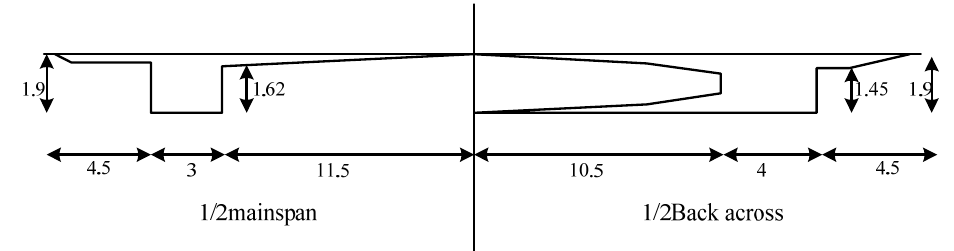
Figure 1: The girder’s sectional view of cable-stayed bridge (unit: m).